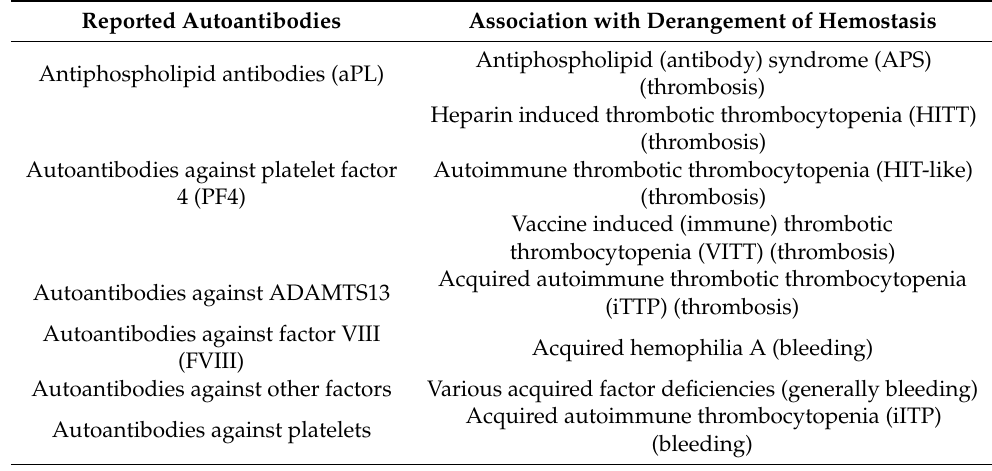
Autoantibodies against